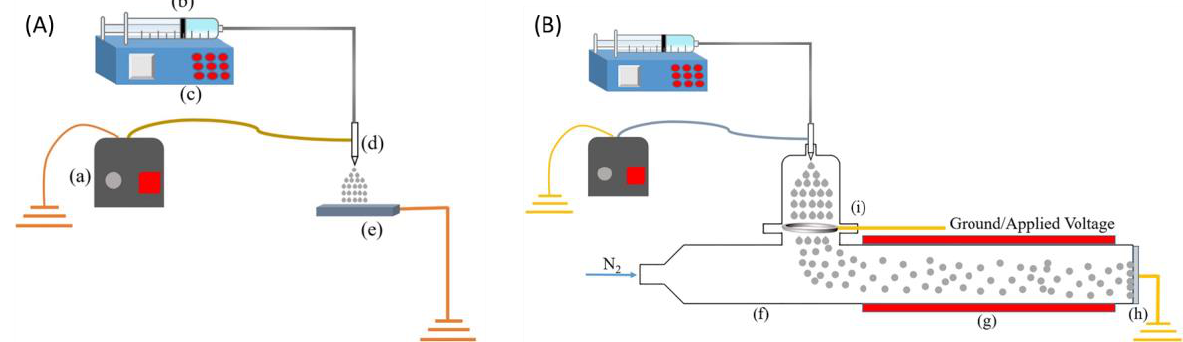
Figure 1. ( A ) Conventional electrohydrodynamic atomization setup; ( B ) electrospray pyrolysis setup. (a) High-voltage power supply; (b) syringe; (c) syringe pump; (d) nozzle; (e) aluminum foil collection substrate; (f) pyrolysis reactor; (g) heating device; (h) aluminum foil with holes; (i) ring electrode.